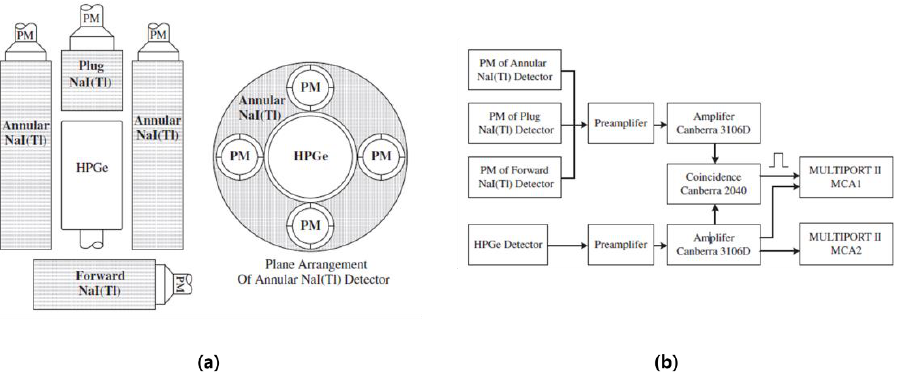
Figure 12. Compton suppression system ( a ) and electronic circuit ( b ) fabricated by CTBT Beijing National Data Centre [39].